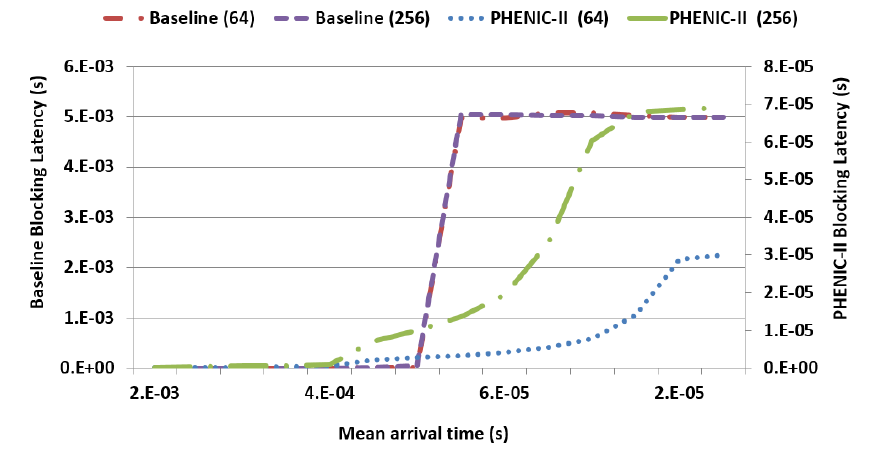
Figure 7. Average blocking latency comparison under uniform